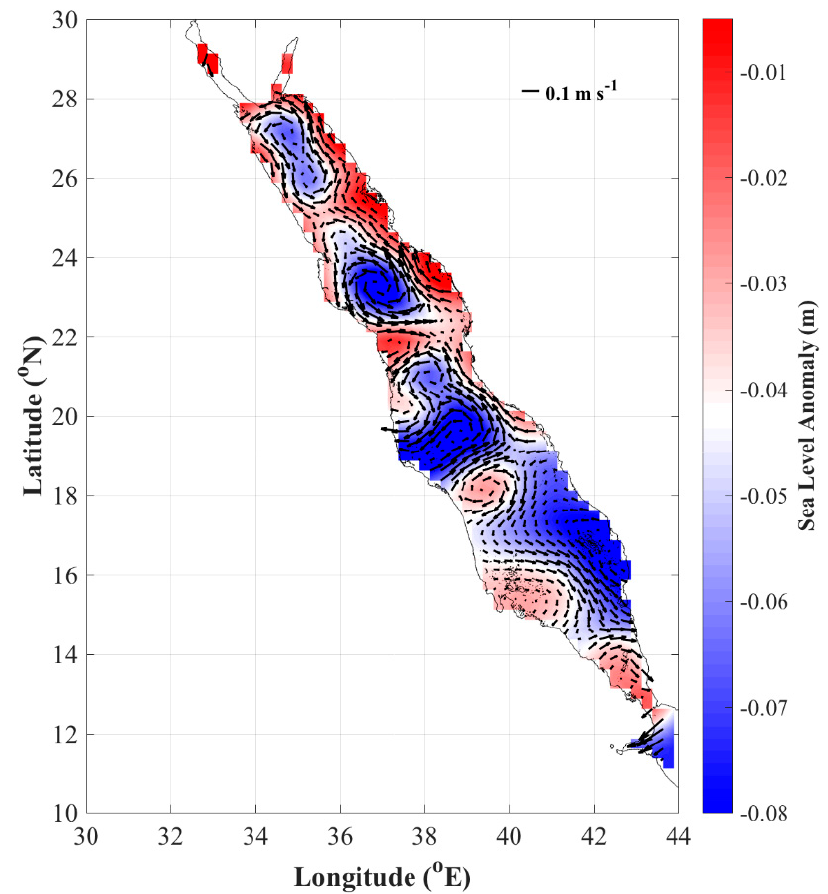
Figure 6. Average sea level anomaly (m) between 15 September and 15 October 2002. Values shown in red (blue) represent a higher (lower) sea level anomaly (SLA), respectively. Regions highlighted in blue represent cyclonic structures, whilst anti-cyclonic features are shown in red. The black arrows indicate the geostrophic velocities anomaly and highlight the mesoscale eddy dipole in in the central Red Sea.